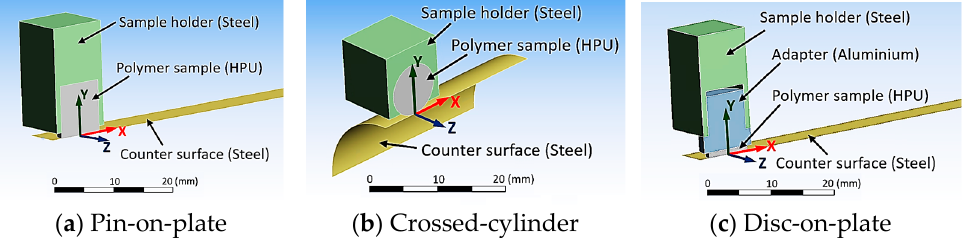
Figure 2. Experimental setup to characterize the tribological behavior of soft polymers with ( a ) polymer pin-on-plate, ( b ) crossed-cylinder configuration and ( c ) a thin polymer disc-on-plate configuration.